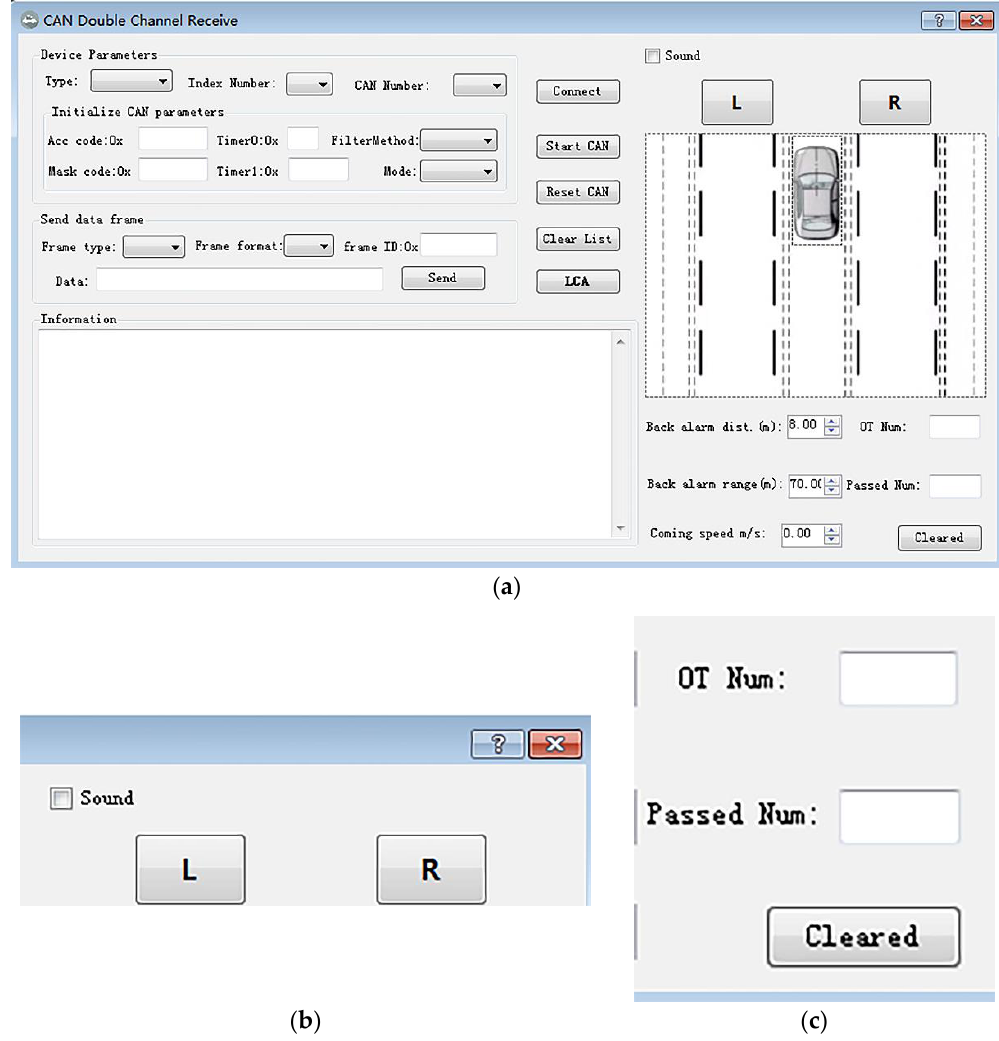
Figure 2. The detection software interface developed in this paper: ( a ) Software interface diagram, ( b ) Identify the keys to the left and right of the target, ( c ) Record the number of overtaking/overtaken vehicles.